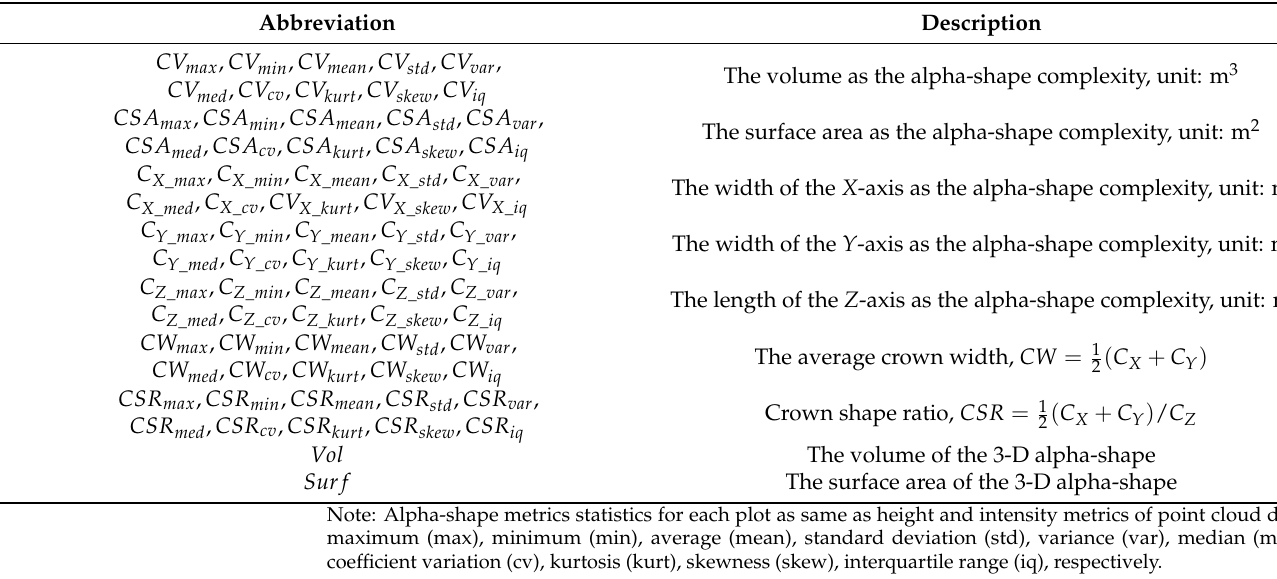
Table 5. Tree crown metrics of alpha-shape complexity derived.